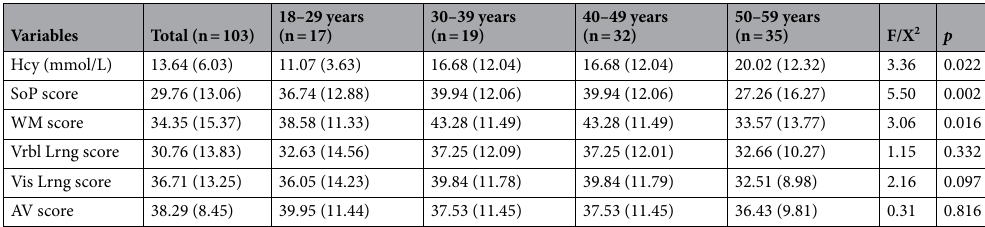
Table 2. Clinical profiles of schizophrenia patients across ages group. Hcy homocysteine, SoP speed of processing, WM working memory, Vrbl Lrng verbal learning and memory, Vis Lmg visual learning and memory, AV attention/vigilance.